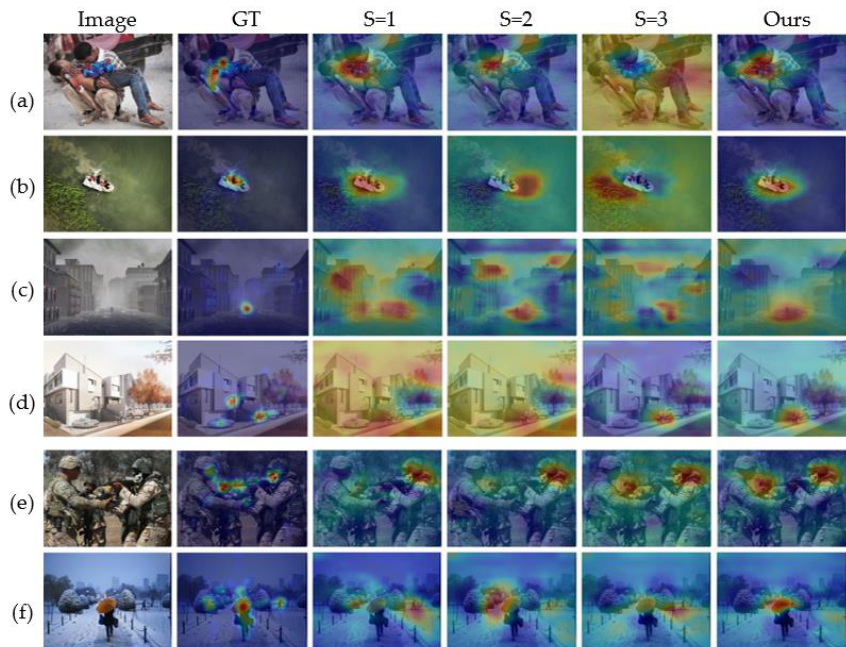
Figure 11. Visualization of the proposed model on EMod. Here we compare with different scale of S = 1, S = 2, S = 4. Our method uses S = [1,2,4]. GT is the ground truth. As shown in ( a – e ), sometimes single-scale or multi-scale can effectively perceive objects related to sentiment, but in complex situations such as ( f ), multi-scale is more effective than single-scale.